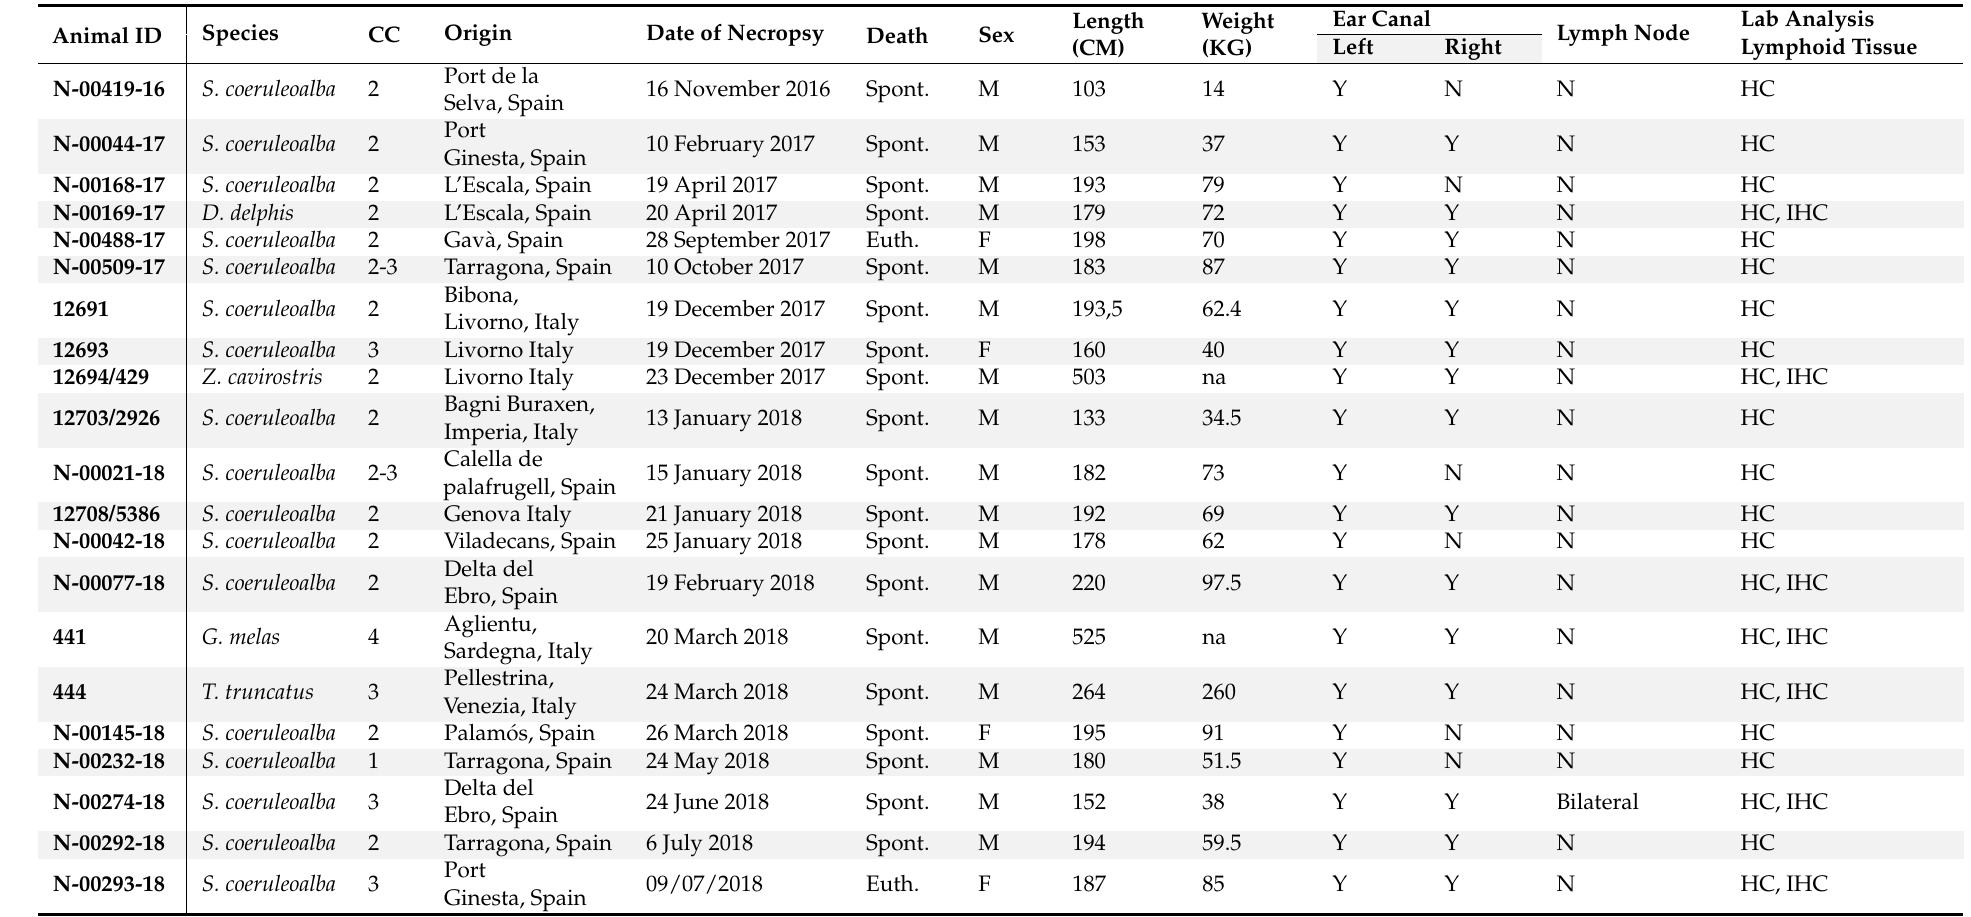
Table A1. The animals used in this study. CC—conservation code (according to IJsseldijk et al., 2019 [17]); HC: histochemistry; IHC: immunohistochemistry; Y: Yes; N: No; M: Male; F: Female; na: not